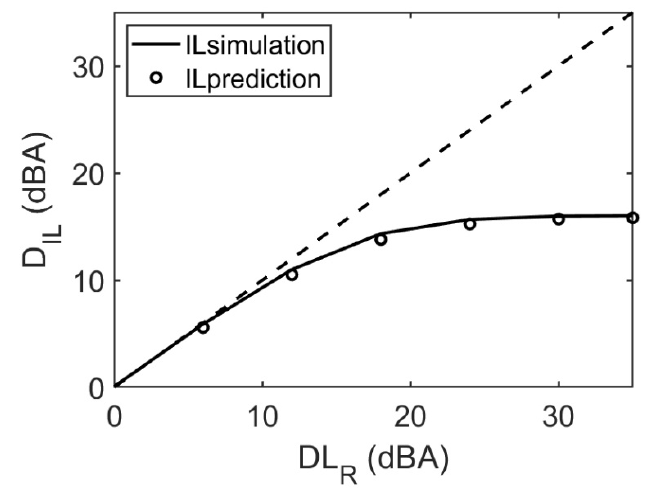
Figure 5. Relationship between global IL ( DL IL ) and DL R indexes. Black dashed line indicates the ideal behaviour of a noise barrier if diffraction at the upper edge is not considered (infinite height). Continuous line represents the variation of DL IL index as a function of DL R index obtained by the numerical FDTD simulation. Dots represent the global IL index obtained by the simple method proposed in this work (Equation (5)). Table 1. Comparison of the values of global IL ( DL IL ) obtained from the FDTD numerical simulation and the simple model proposed in this work (Equation (5)) for different values of the airborne sound insulation ( DL R ). The absolute differences are always below a JND (1 dBA).